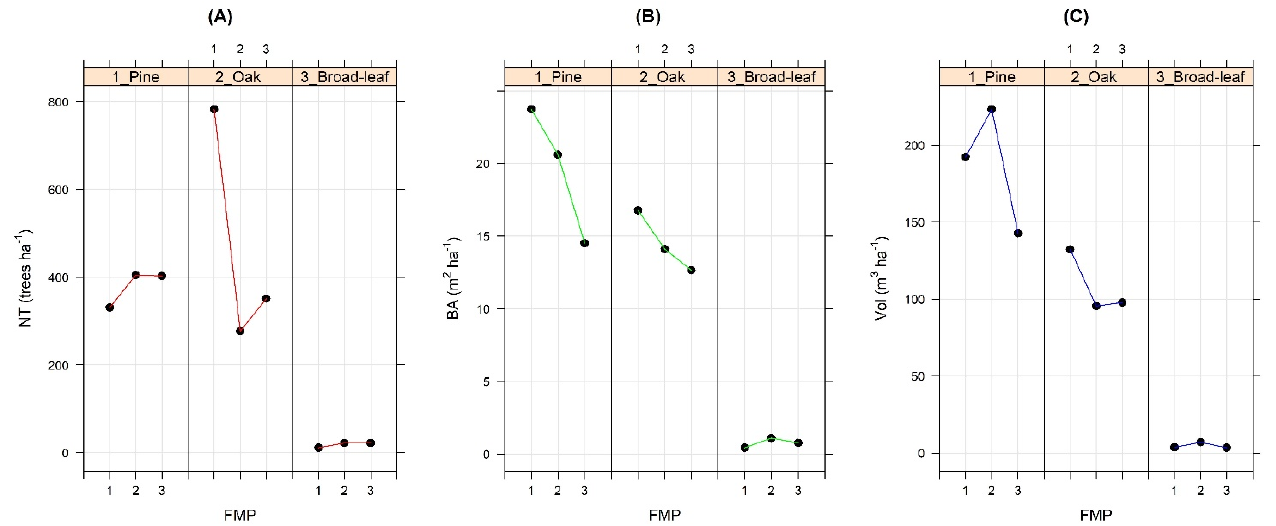
Figure 6. Comparison of number of trees ( NT ) ( A ), basal area ( BA ) ( B ), and volume ( Vol ) ( C ) of the three forest management plans (FMPs) in the K0605 sub-stand.